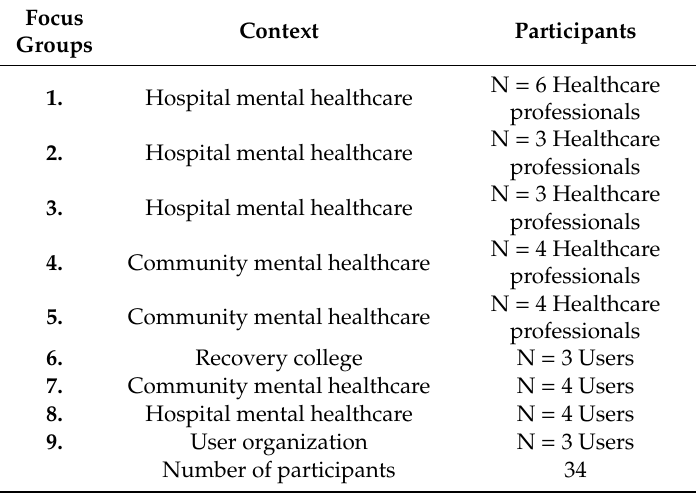
Table 1. Focus groups, context, and